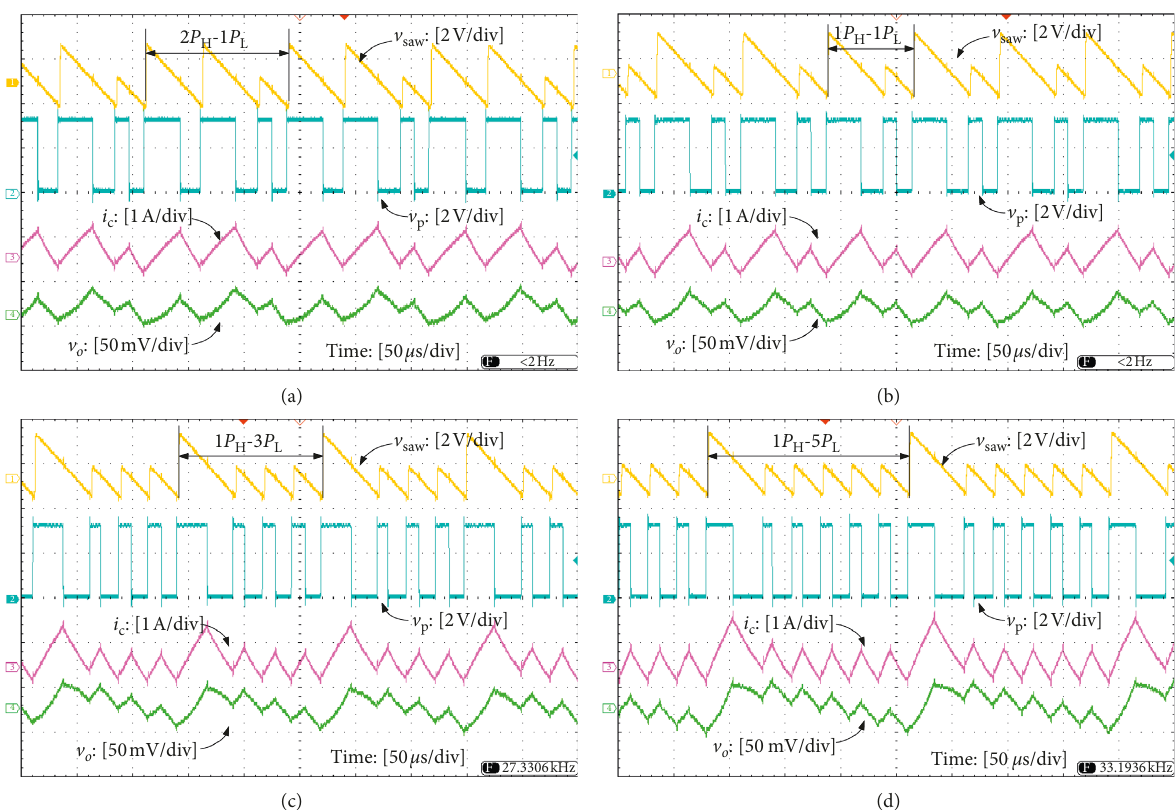
Figure 8: Experimental waveforms of the DCPT-controlled buck converter. (a) V